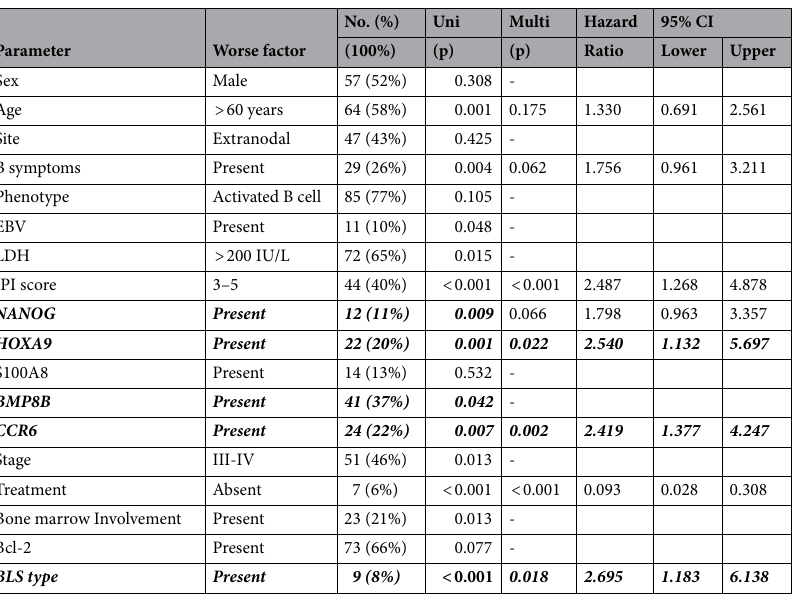
Table 1. Clinicopathologic parameters affecting overall survival of patients with DLBCL (n = 110). Bolditalics denote statistical significance. Uni: univariate analysis; Multi: multivariate analysis; CI: confidence interval; EBV: Epstein-Barr virus; LDH: lactate dehydrogenase; IPI: international prognostic